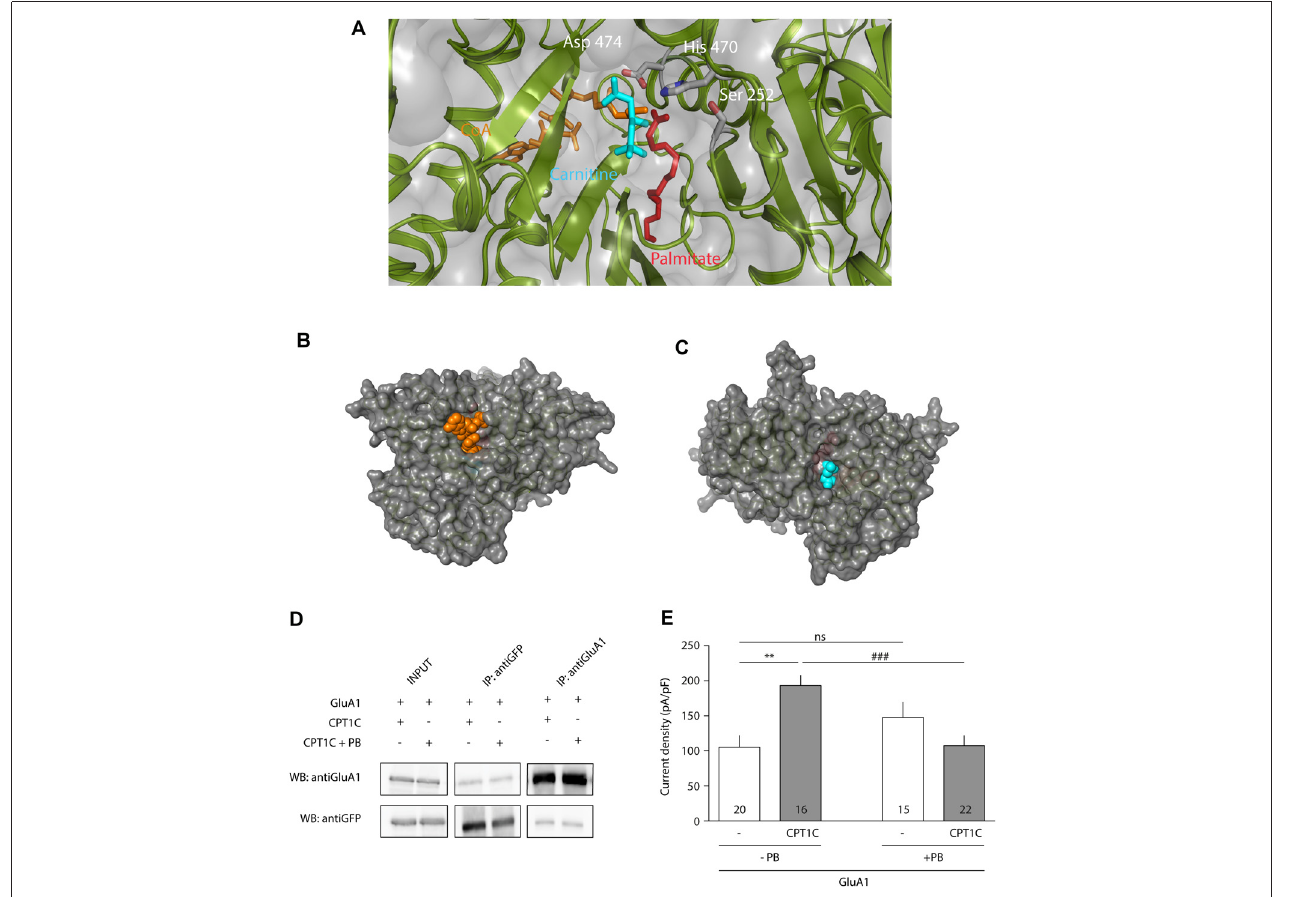
FIGURE 5 | CPT1C displays depalmitoylation features. (A) Molecular model of CPT1C complexed to carnitine, CoA and palmitate. Ser 252, His 470 and Asp 474 are pointing toward the binding pocket and are proposed to be the catalytic residues in CPT1C depalmitoylating activity. (B) CoA (in orange) is observed in CPT1C molecular model, suggesting that the substrate (small region of GluA1) could access to the binding pocket through this cavity. (C) A cavity next to carnitine (in blue) is also observed, suggesting that palmitoylcarnitine can exit the binding pocket through this cavity. (D) Coimmunoprecipitation showing that Palmostatin B (PB)—an inhibitor of palmitoyl thioesterase (PTE) activity—treatment does not affect the interaction of CPT1C with GluA1. (E) Average of normalized current density at − 80 mV for GluA1 alone (+GFP) or together with CPT1C with and without treatment with PB. CPT1C increased GluA1 current density in the absence of PB ( ∗∗ p < 0.01; Mann-Whitney-U-test). Current density was decreased to control levels (GluA1 alone) when cells co-expressed GluA1 and CPT1C but treated with PB ( ### p < 0.001; Mann-Whitney-U-test). There was no statistical difference in GluA1 current density when expressed alone, with or without PB treatment ( ns p > 0.05; Mann-Whitney-U-test). Numbers in bars represent the number of recorded